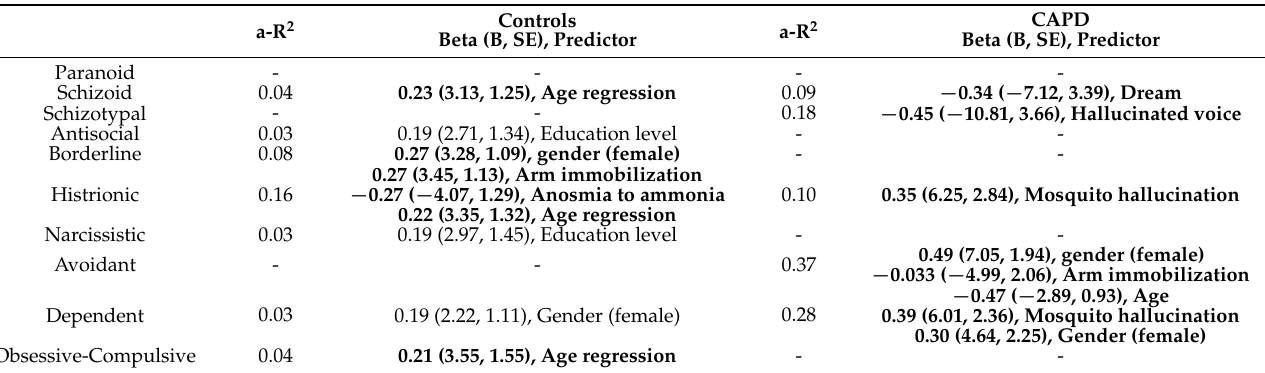
Table 4. Predictions of personality disorder functioning styles of the Parker Personality Measure by performance on the Stanford Hypnotic Susceptibility Scale: Form C (gender and age as covariates) using stepwise regression analysis in healthy volunteers (controls, n = 115) and cluster A personality disorders (CAPD, n =